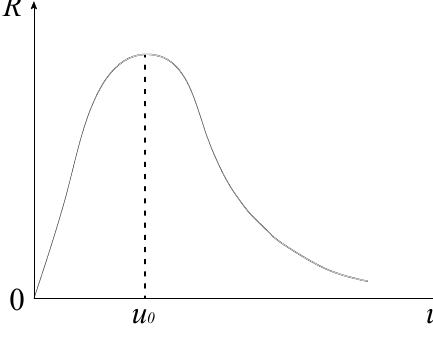
Figure 9. Stress – strain curve of rocks. Figure 9. Stress–strain curve of